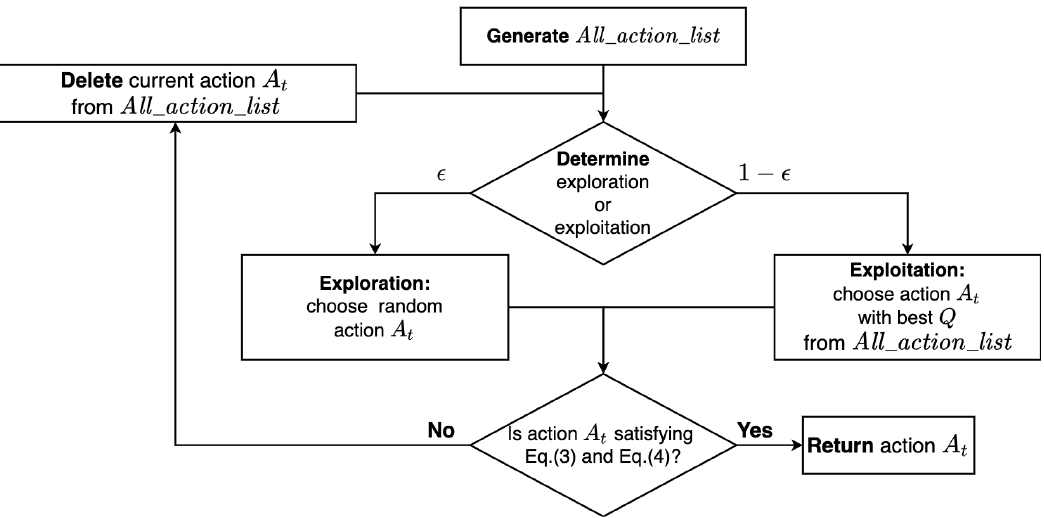
Figure 5. The flow of UAV action determination at each action instance of each episode. The termination criteria are the conditions when the demands for all shelters are